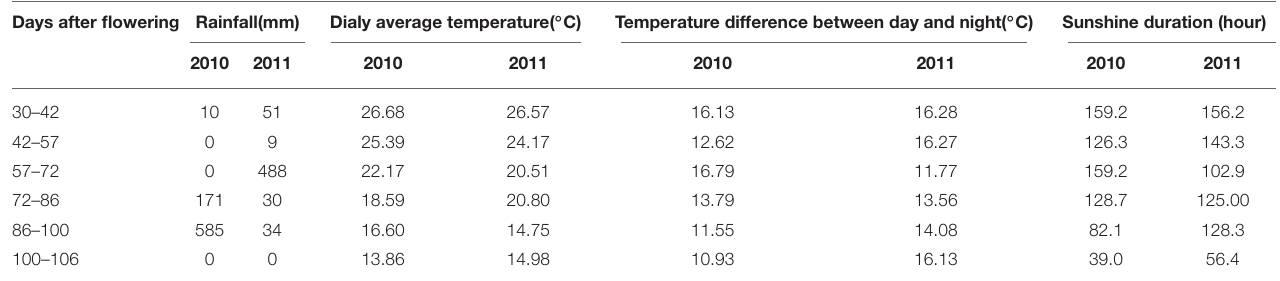
“30–42” indicates the 30th to 42nd day after flowering, so are the rest.